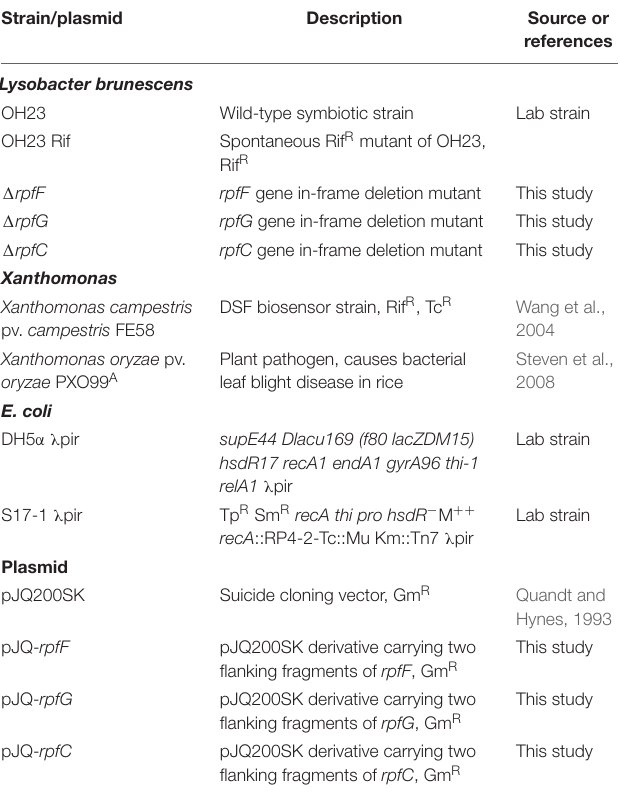
TABLE 1 | Bacterial strains and plasmids used in this